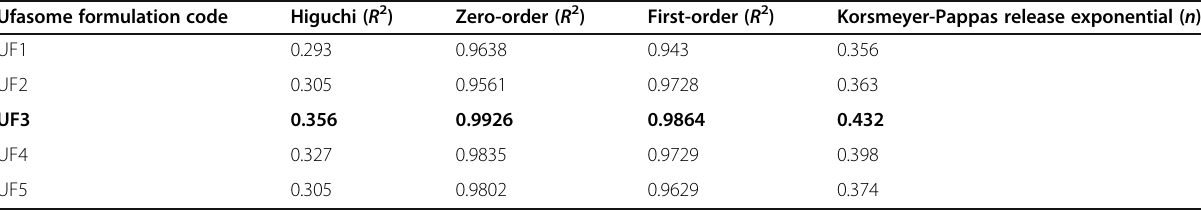
Table 2 Kinetic profiling of different ufasome formulation Ufasome formulation code